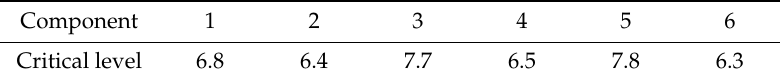
Table 3. Maintenance decision variables under minimum LACR.